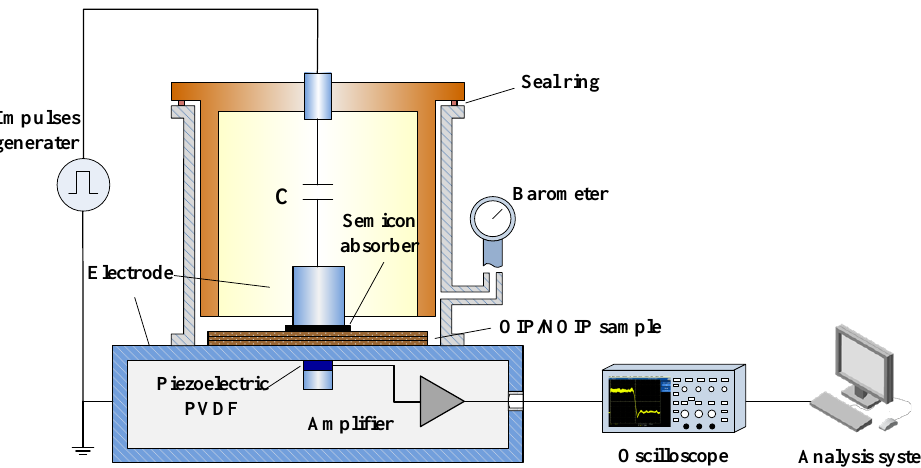
Figure 3. Schematic diagram of Pulsed Electro-Acoustic (PEA) test system.